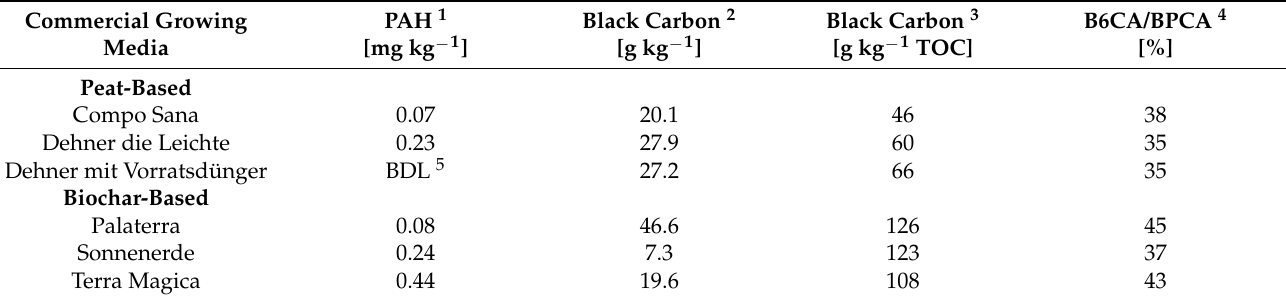
Table 2. Polycyclic aromatic hydrocarbons (PAH) and black carbon of commercially available peat- and biochar-based growing media used in this